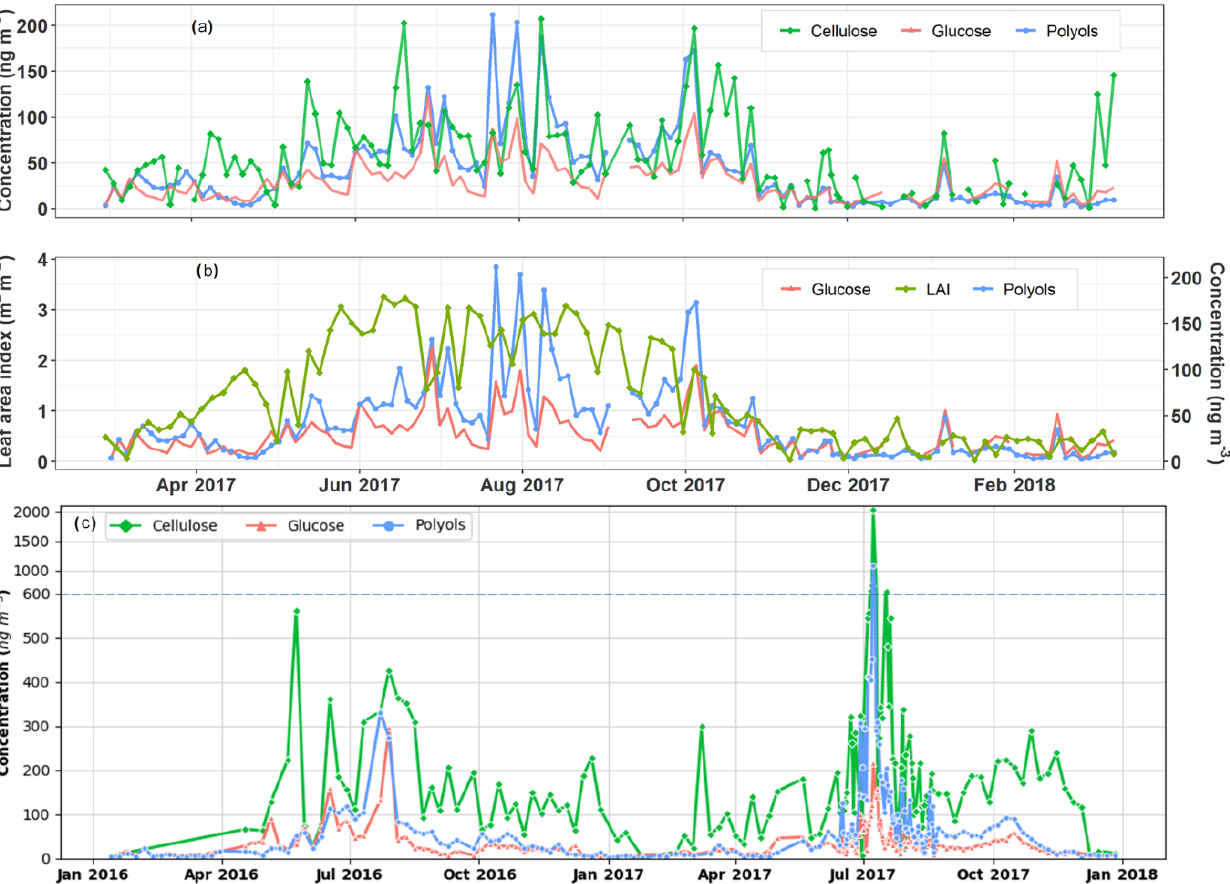
Figure 5. Temporal covariation cycles of the daily particulate polyol and glucose concentrations along with vegetation indicators at the urban background site of Grenoble (a, b) and the rural agricultural background site of OPE-ANDRA (c) . Note that PM 10 aerosols are intensively collected at OPE-ANDRA every day (24h) from 12 June to 22 August 2017 and that the concentration scale changes above 600ngm − 3 in (c) due to an extreme concentration peak in July 2017. The horizontal dashed line denotes this change in y axis